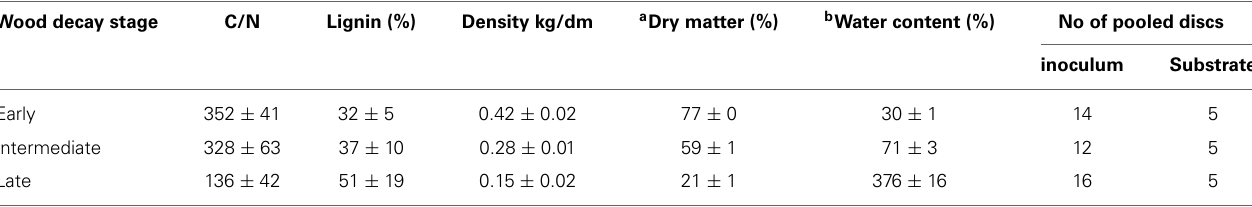
Table 1 | Properties of Norway spruce ( Picea abies ) wood of different decay stages (early, intermediate and late) and the number of pooled discs used to prepare the inoculum (non-sterile sawdust) or the autoclaved sawdust for the microcosms. Wood decay stage